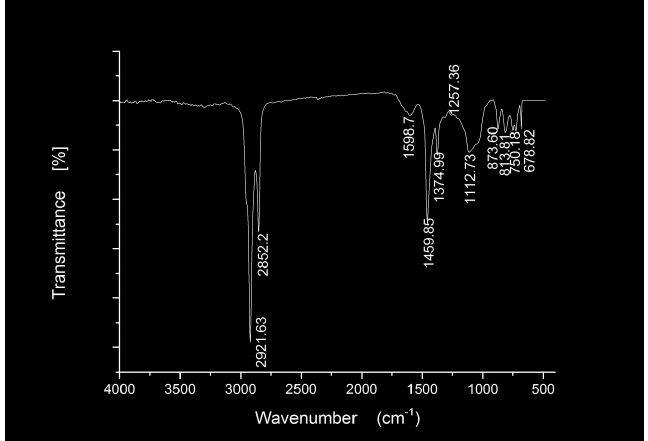
Figure 7. FTIR spectra of the BA-SP.